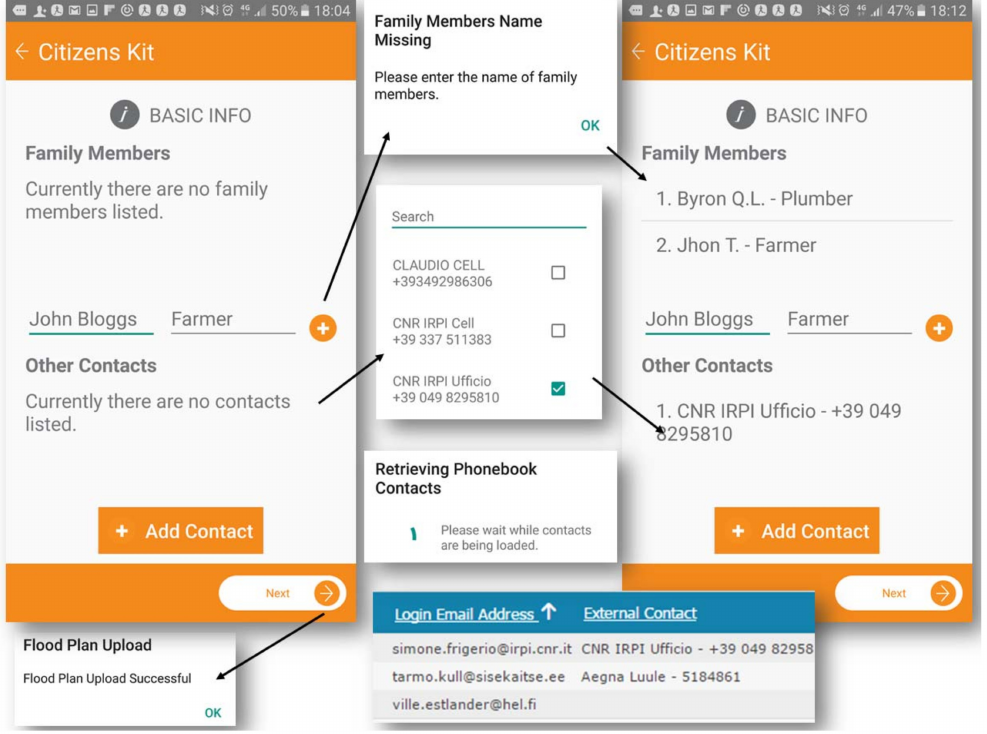
Figure 4. Basic info update about personal